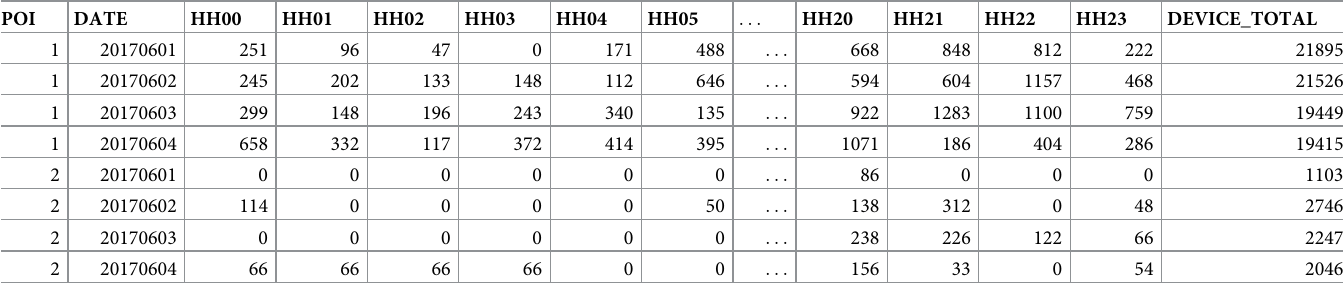
Table 1. Sample of dataset derived from cell phone locations.